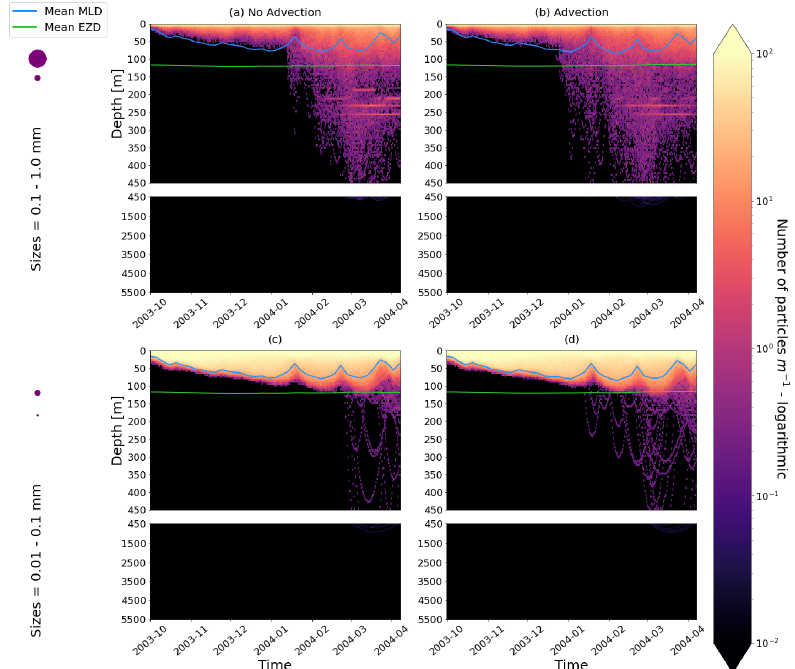
Figure E3. As in Fig. E2 but for particles only in the NPSG. This means that (a) and (c) are identical to Fig. 2b and e, however, including the 3-month spin-up time and running for fewer days (not a full